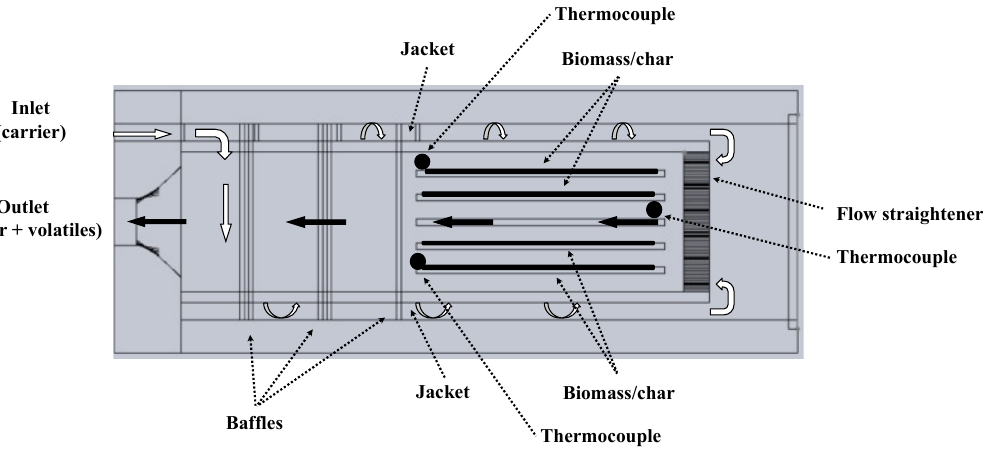
Figure 1. Pyrolysis reactor: Cross-section of the reaction chamber.